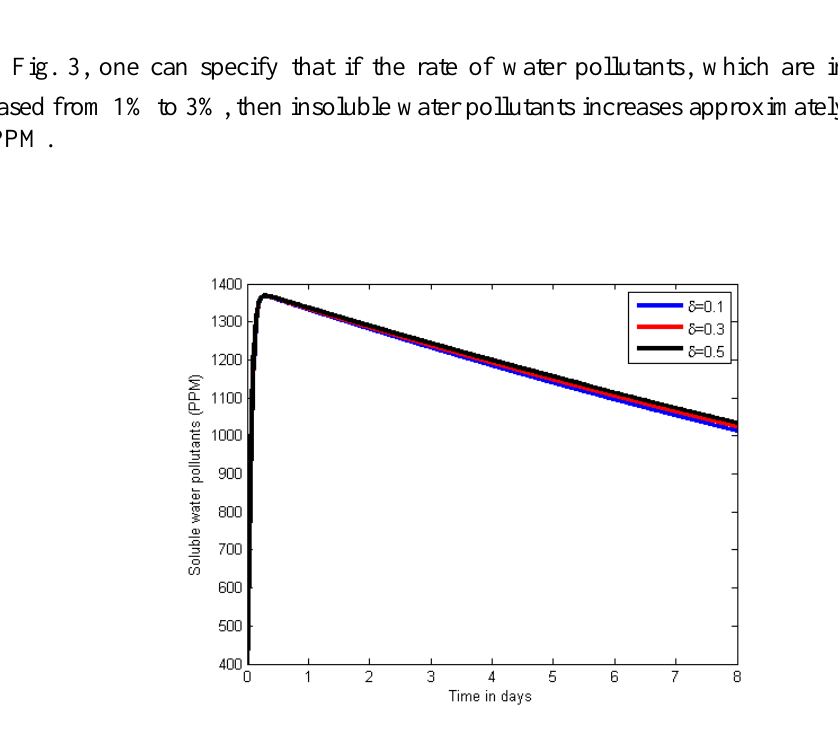
Fig. 4. Effect for the rate of insoluble water pollutants becomes solute after some treatment